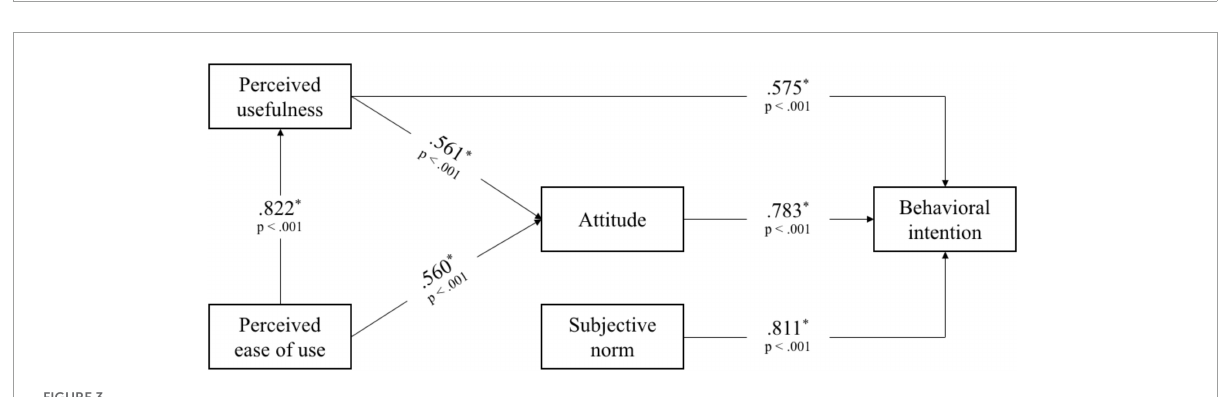
FIGURE3 Results for correlation of variables based on the conceptual